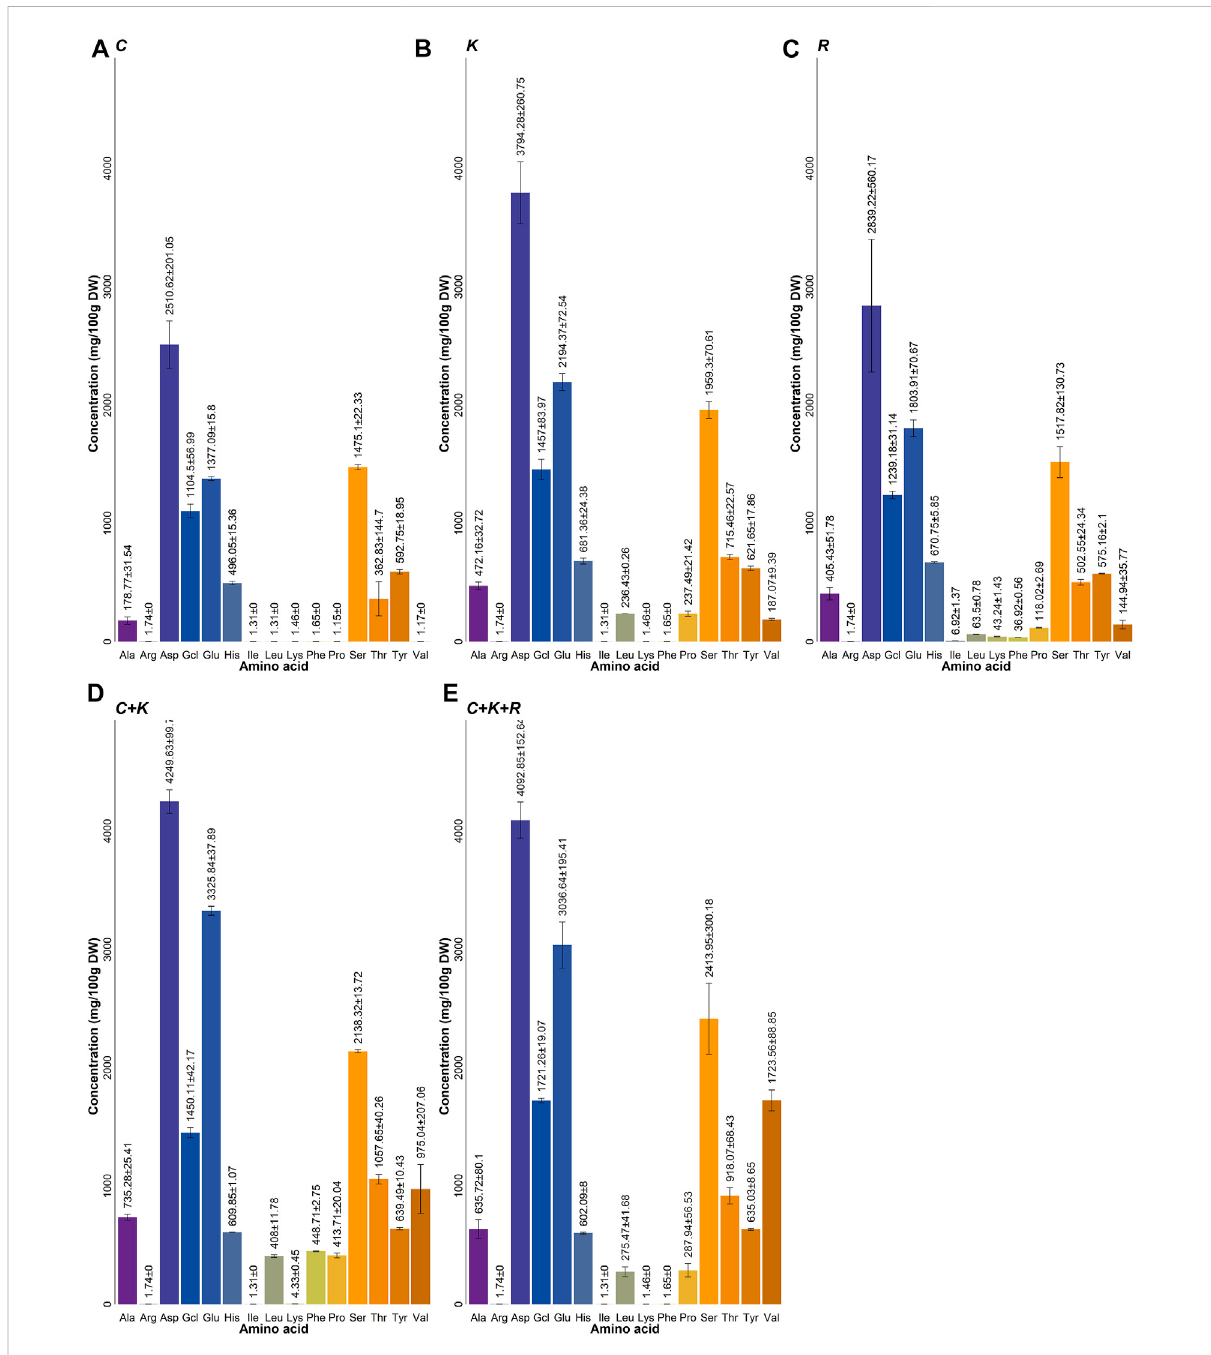
FIGURE 3 Amino acid composition of the yeast culture treatments. (A) , C. utilis ; (B) , K. marxianus ; (C) , R. mucilaginosa ; (D) , Candida utilis + K. marxianus ; (E) , C. utilis + K. marxianus + R. mucilaginosa